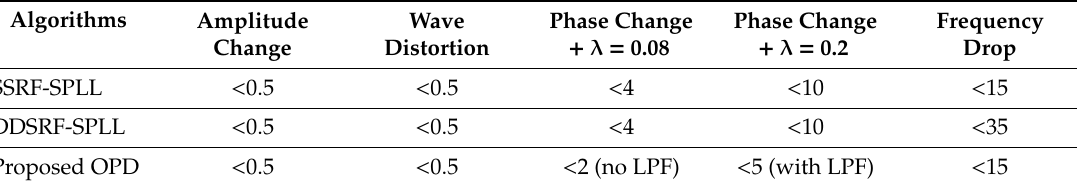
Table 2. Comparison result of dynamic response time